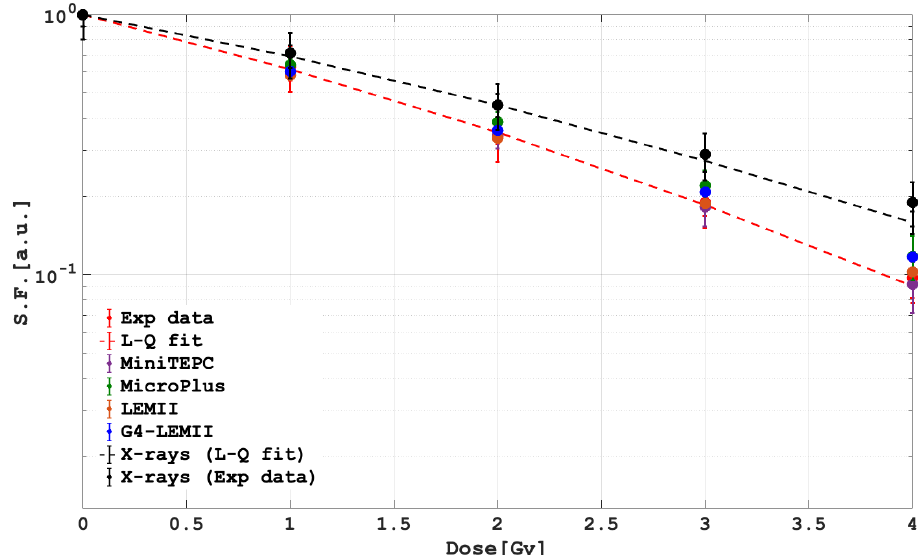
Figure 4. Survival fractions for ARPE19. Biological survival data acquired with proton beam irradiations (red symbols) are plotted together with the linear-quadratic best fit (red dashed line). Biological survival data acquired with gamma rays (black symbols) are plotted together with the best fit (black dashed line). The survival fractions predicted from microdosimetric measurements calibrated on gamma-rays cell survival are also plotted. Purple and green points are related to the mini-TEPC and MicroPlus respectively. The blue points were calculated by coupling the Monte Carlo Geant4 with the LEM-II model. Finally, the orange points are obtained with the LEM-II